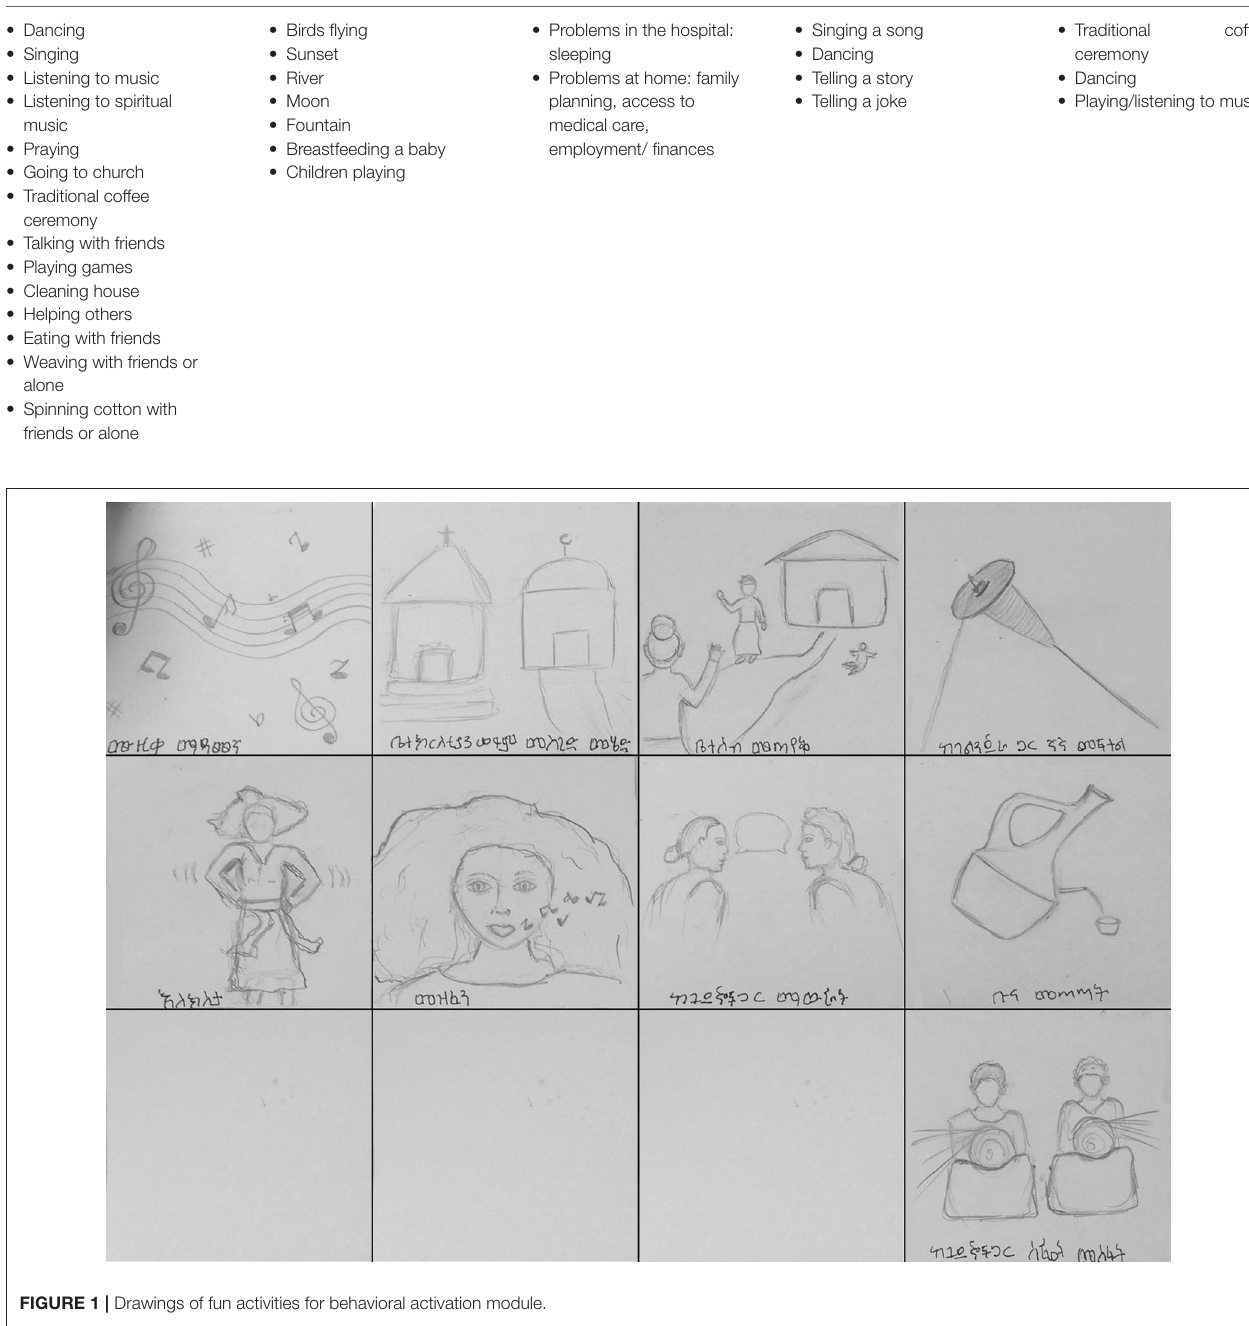
FIGURE 1 | Drawings of fun activities for behavioral activation